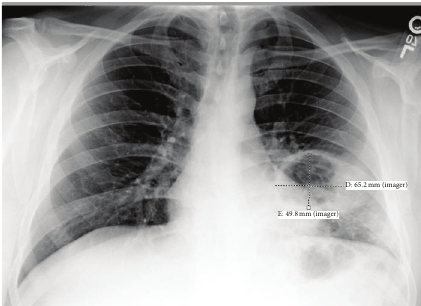
Figure 1: Chest X-ray on admission with 6.52 cm by 4.98 cm cavitary lesion.